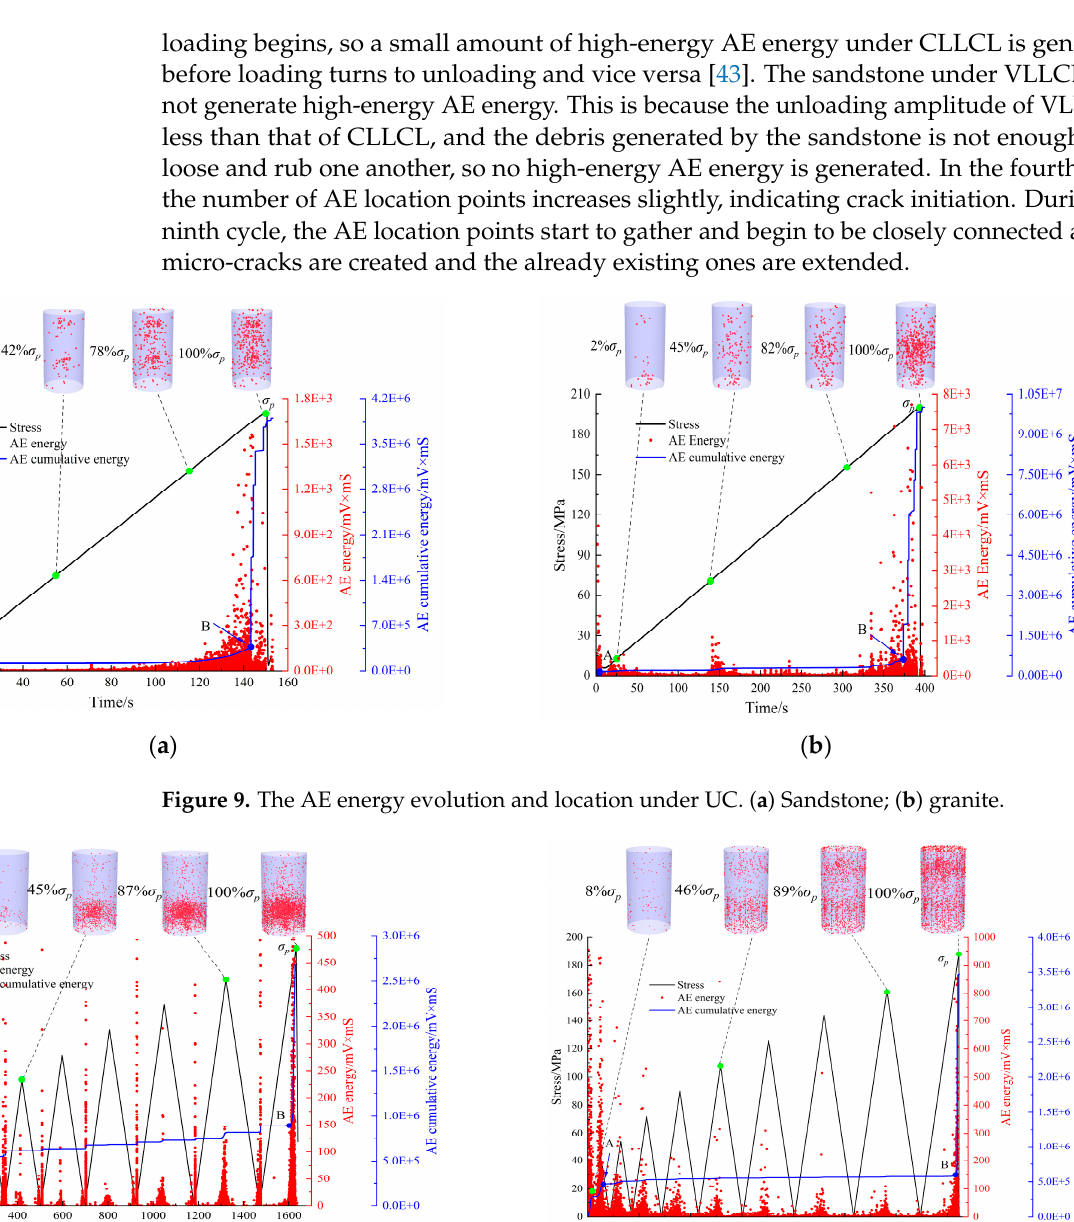
Figure 9. The AE energy evolution and location under UC. ( a ) Sandstone; ( b ) granite.